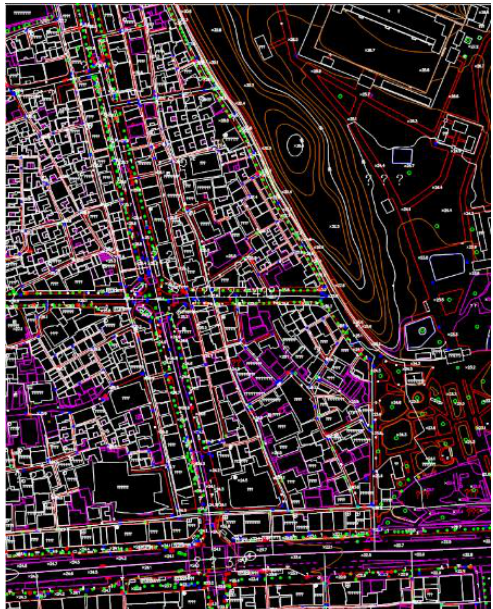
Figure 14. Extracted digital map on target area using UAV image